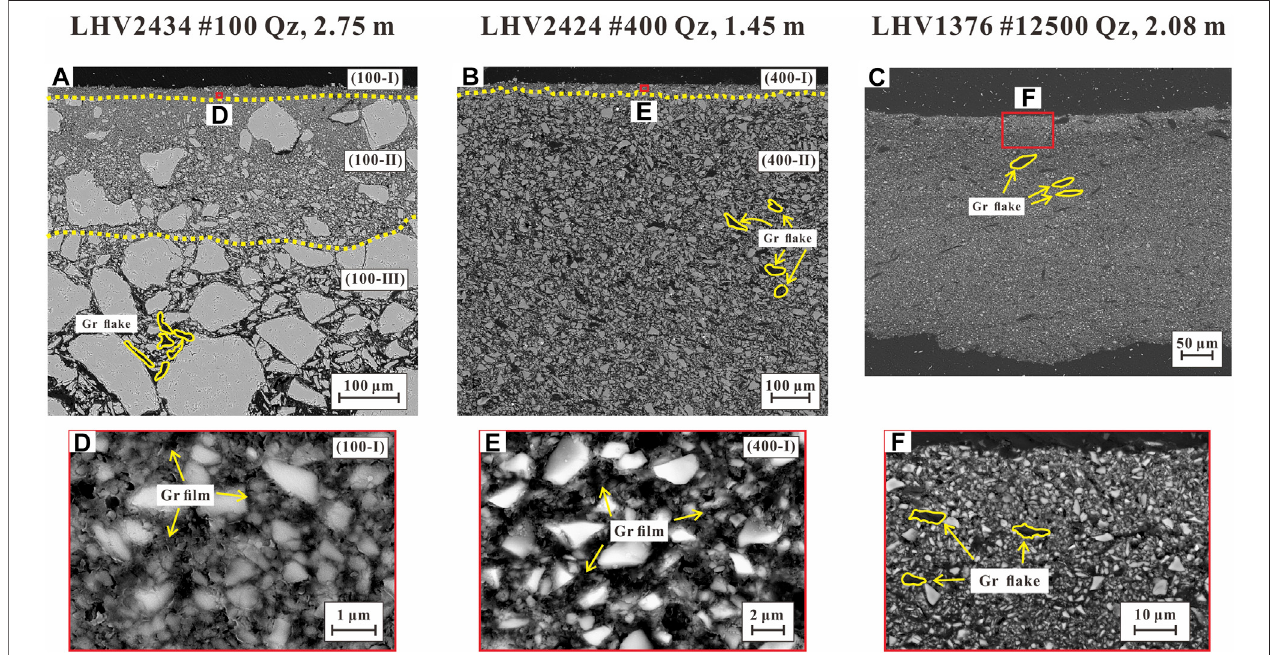
FIGURE5| Backscattered electron (BSE) imagesofrecovered epoxy-impregnatedGr-bearingsyntheticgougesparallel tothespecimenaxis.Theseimages were obtainedbyascanningelectron microscopy (SEM),including (A) #100mesh, (B) #400mesh,and (C) #12500 meshQz-bearingspecimens.Theexperimentalnumbers and total slip displacements are labeled in the graphic titles. The yellow dotted lines in (A) and (B) bound the layers of different strain levels (I to III). (D – F) Close-up views are marked on the red rectangular portions in (A – C) , respectively.